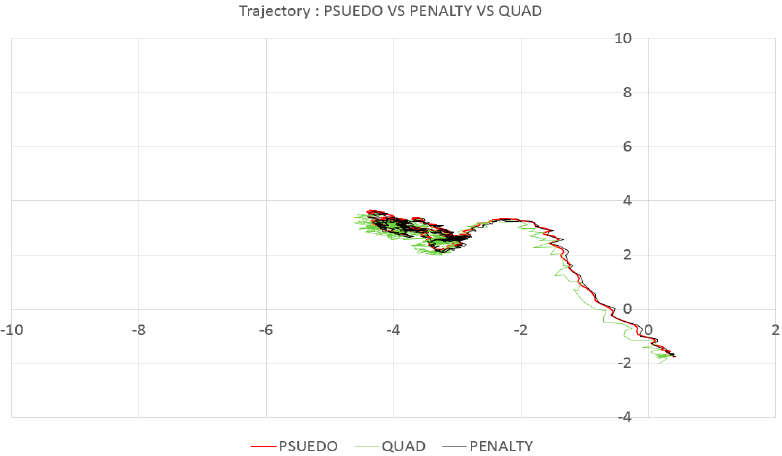
Figure 22 . Surge and Sway Trajectories by Three Different Thrust-Allocation Algorithms. Figure 22. Surge and Sway Trajectories by Three Different Thrust-Allocation